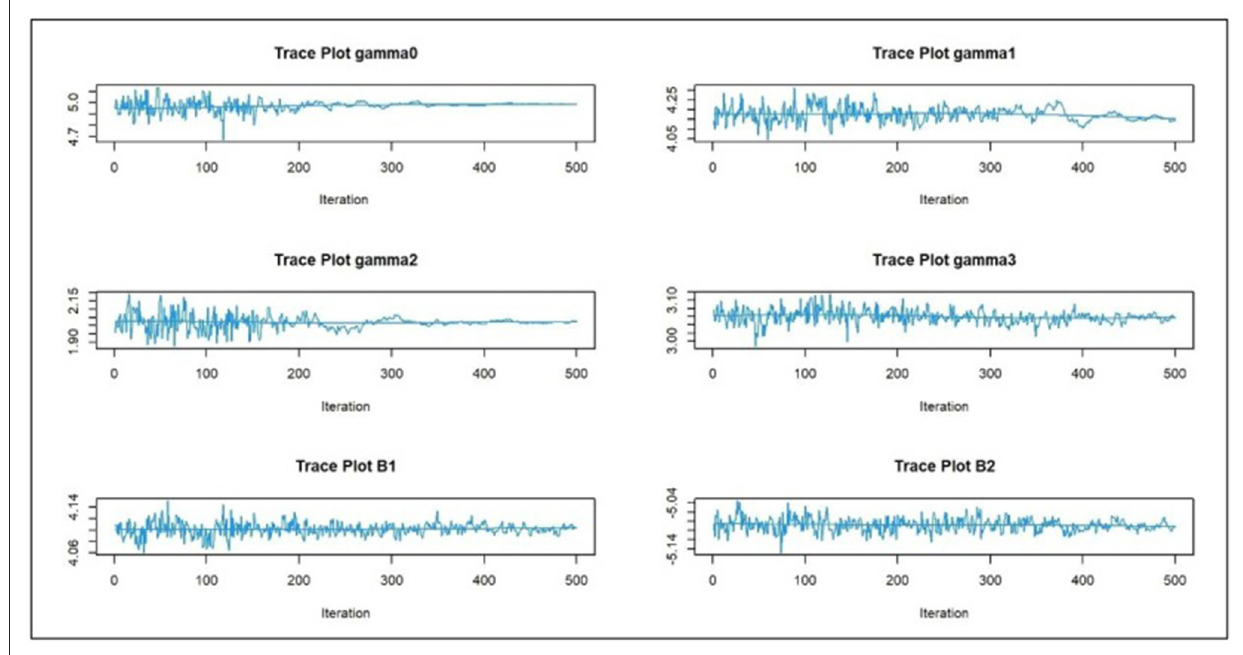
FIGURE2 Sample of the trace plot for the SAEM estimates ( n = 100), ε τ , ij ∼ ALD .